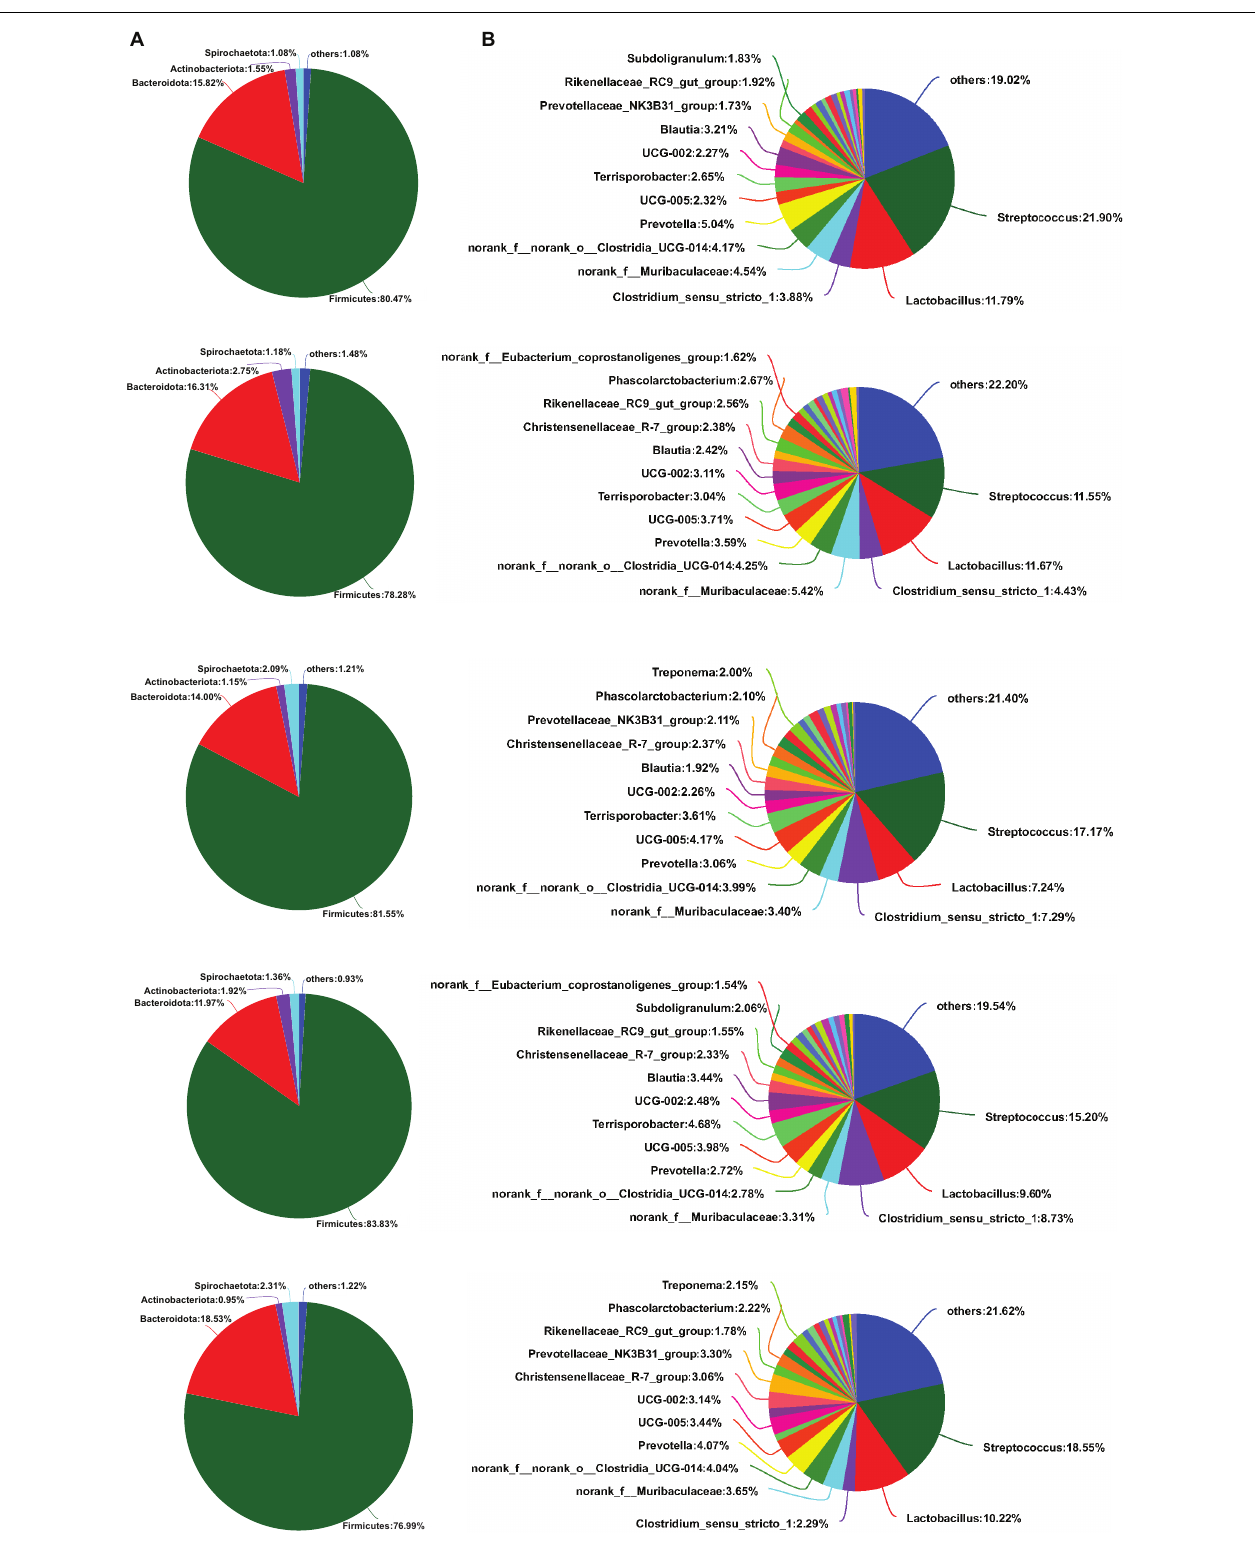
FIGURE 6 | Effects of different diets on the fecal bacterial community structure in weaned piglets. (A) Distribution of fecal bacteria at phylum level in weaned piglets. (B) Distribution of fecal bacteria at the genus level in weaned piglets.